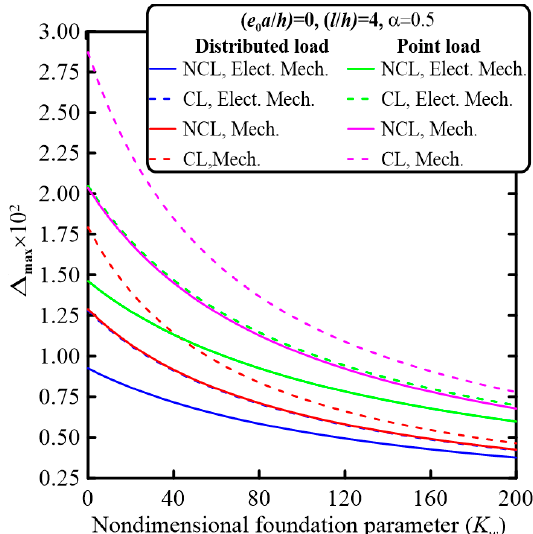
Figure 4. Variation in the maximum transverse deflection Δ max with the nondimensional elastic foun- dation parameter K w for nonclassical and classical electromechanical and mechanical behaviors un- der uniformly distributed and point loads at different values of perforation filling ratio, α = 0.25 and 0.5, at N = 4 and beam aspect ratio L / h = 20, e 311 = − 4.1 C/m 2 , μ 3111 = 5 × 10 − 8 C/m, a 33 = 7.124 × 10 − 9 C/m 2 K, and K p = 0. For deep investigation of the influence of the elastic foundation parameter K w on the maximum nondimensional transverse deflection, the relative percentage difference of the maximum transverse deflection due to increasing the nondimensional elastic foundation parameter Kw is given by (%𝐷∆ (cid:3040)(cid:3028)(cid:3051) ) (cid:3012) (cid:3298) = 100 × 𝑎𝑏𝑠 (cid:3428) (∆ (cid:3288)(cid:3276)(cid:3299) ) (cid:3260)(cid:3298)(cid:3128)(cid:3116) (cid:2879)(∆ (cid:3288)(cid:3276)(cid:3299) ) (cid:3260)(cid:3298)(cid:3128)(cid:3118)(cid:3116)(cid:3116) (∆ (cid:3288)(cid:3276)(cid:3299) ) (cid:3260)(cid:3298)(cid:3128)(cid:3116) (cid:3432). The rela- tive percentage difference ( %𝐷∆ (cid:3040)(cid:3028)(cid:3051) ) (cid:3012) (cid:3298) for the electromechanical and mechanical non- classical and classical behaviors at different values of α and nonclassical parameters for